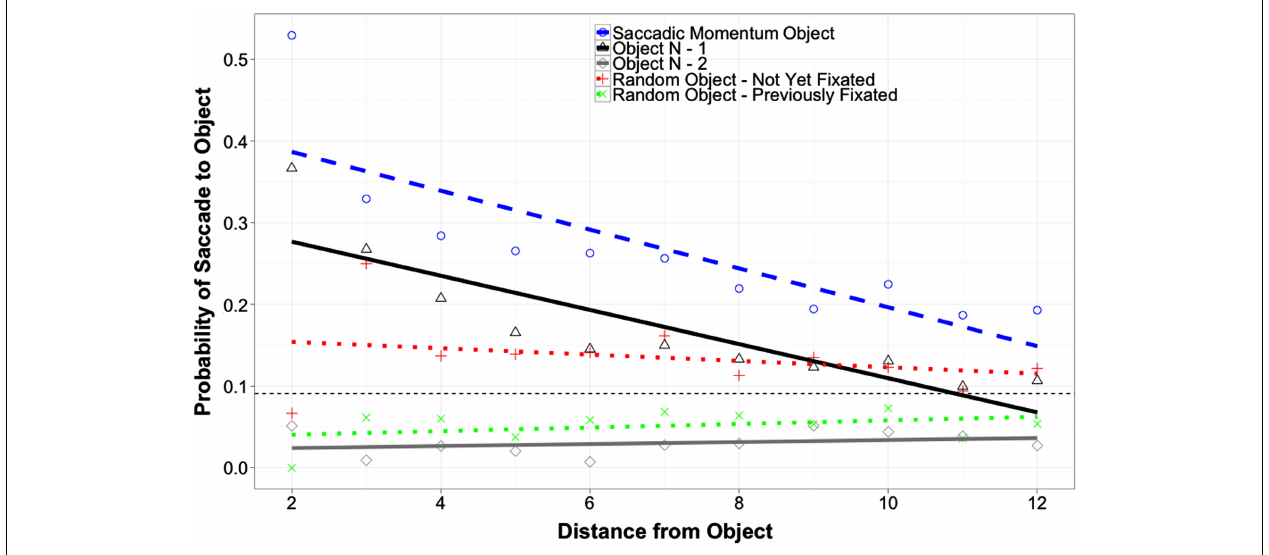
FIGURE 4 | Probability of saccade to an object as a function of object and of distance from that object (in degrees of visual angle). The small horizontal dashed line represents the random chance probability of a saccade from the currently fixated object to any of the other objects in the